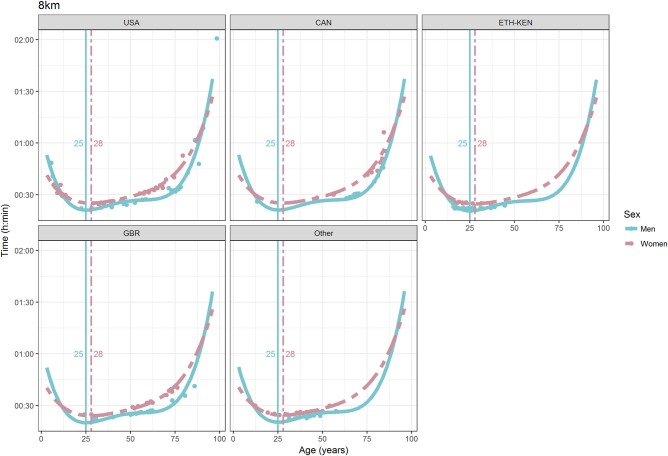
World record in 8 km by sex, age (in years), and country. Points were observations. Curves represented quartic degree polynomial regression. Vertical lines with numeric labels were the ages at peak performance.